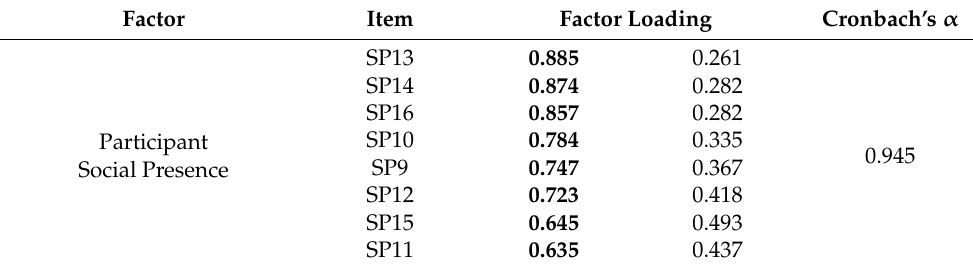
Table 6. Exploratory factor analysis and reliability for social